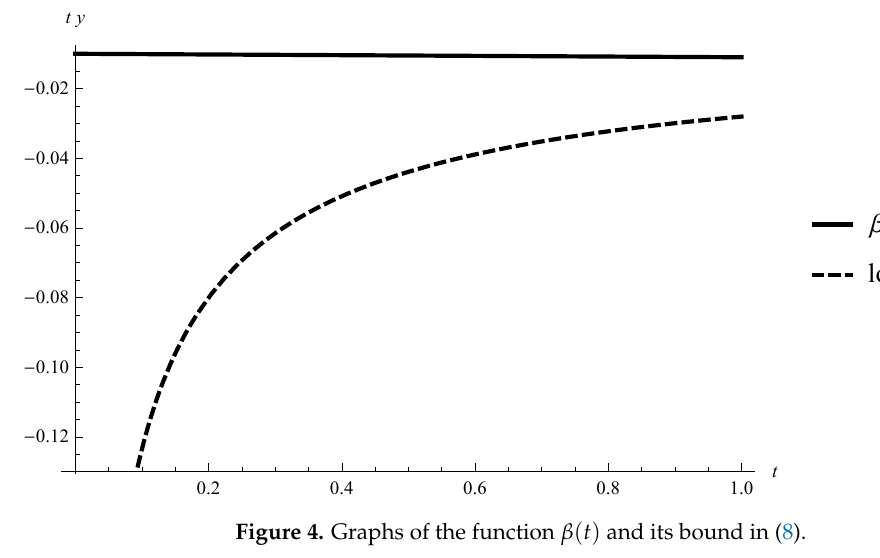
Figure 4. Graphs of the function β ( t ) and its bound in